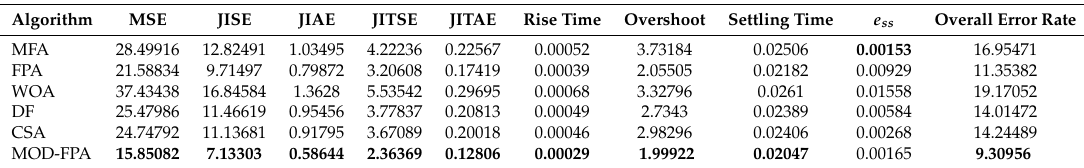
Table 12. Performance analysis, Case 3.